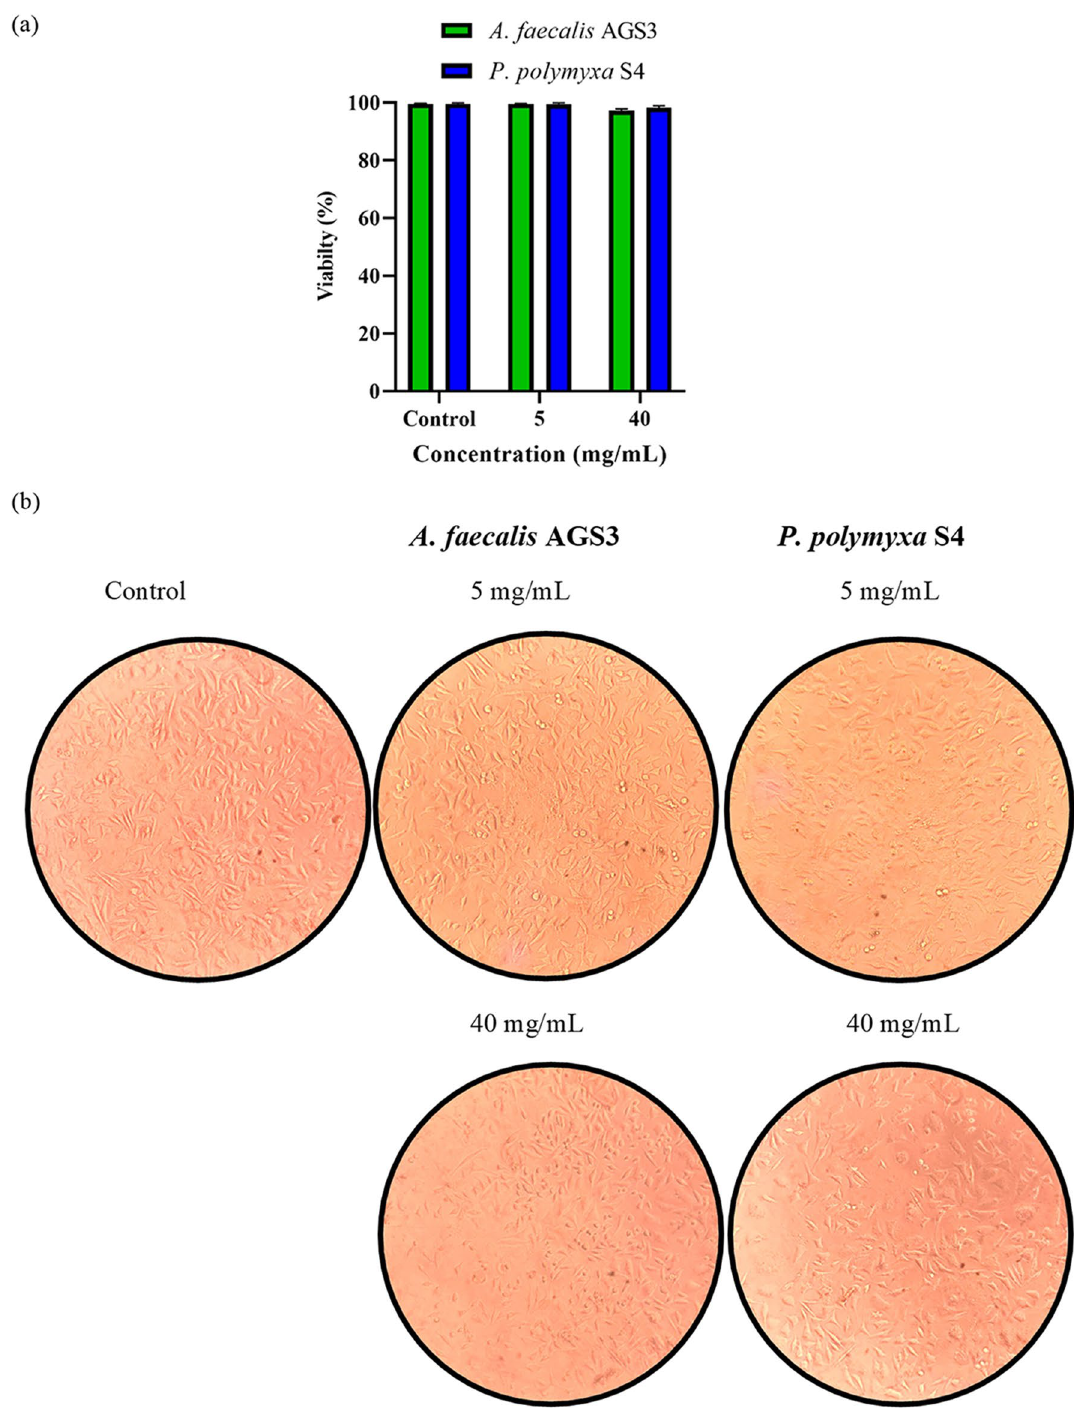
Figure 7. Cytotoxicity assessment of obtained POSs on L-929 cells after 48 h incubation. ( a ) MTT assay results of treated cells showed no significant cytotoxicity in comparison to control. ( b ) Microscopic analysis of treated cells showed no change in morphology of cells compared to